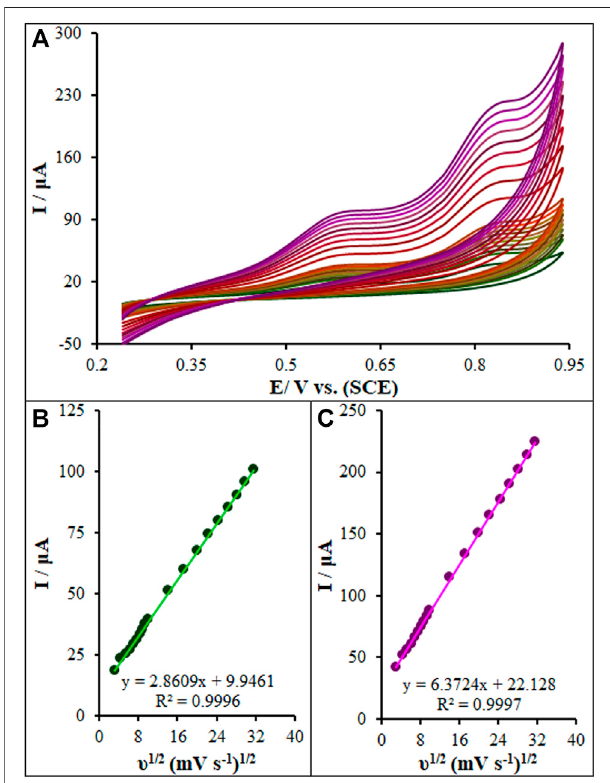
FIGURE 9 | (A) CVs of La 2 O 3 @SF-L Cu 2 S/GCE in pH 7.0 in the presence of diclofenac (275.0 µM) and chlorzoxazone (275.0 µM) at various scan rates (from inner to outer curve): 10, 20, 30, 40, 50, 60, 70, 80, 90, 100, 200, 300, 400, 500, 600, 700, 800, 900, and 1000 mV/s. (B) The plots of peak currents vs υ 1/2